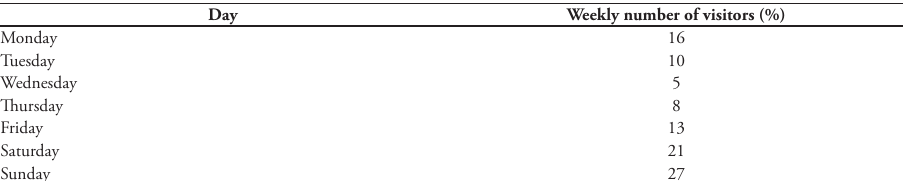
table 4. Weekly number of visitors (%) in the summer who visit Lyme Park. Values are based on relative numbers of visitors extracted from Google analytics (see methodology for further